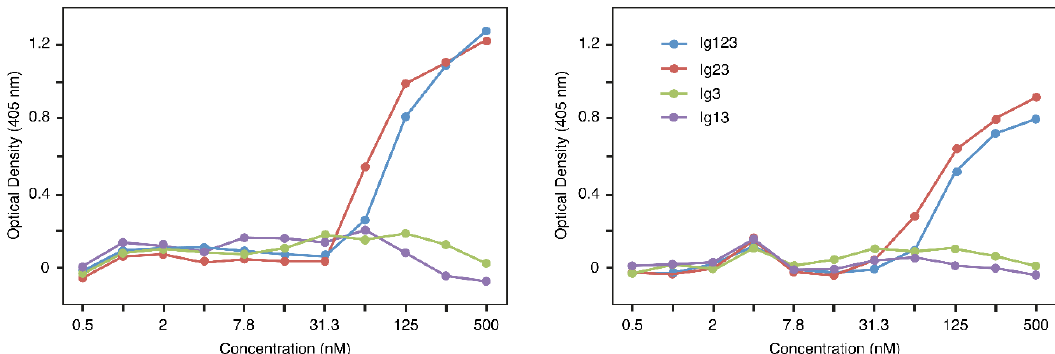
Figure 3. ELISA demonstrating binding of FGFRL1 constructs to fibroblast growth factor (FGF) 8. Microtiter plates were coated with FGF8 and twofold serial dilutions of four different FGFRL1 polypeptides were incubated in the wells. Bound polypeptides were detected with a monoclonal antibody against human FGFRL1, followed by a secondary enzyme-conjugated antibody. The figure shows two representative examples from a total of three assays that yielded very similar results. The color reaction was allowed to proceed for 120 min in the assay shown at the left, for 90 min in the assay shown at the right. Note that Ig123 and Ig23 bind with similar affinity to FGF8.